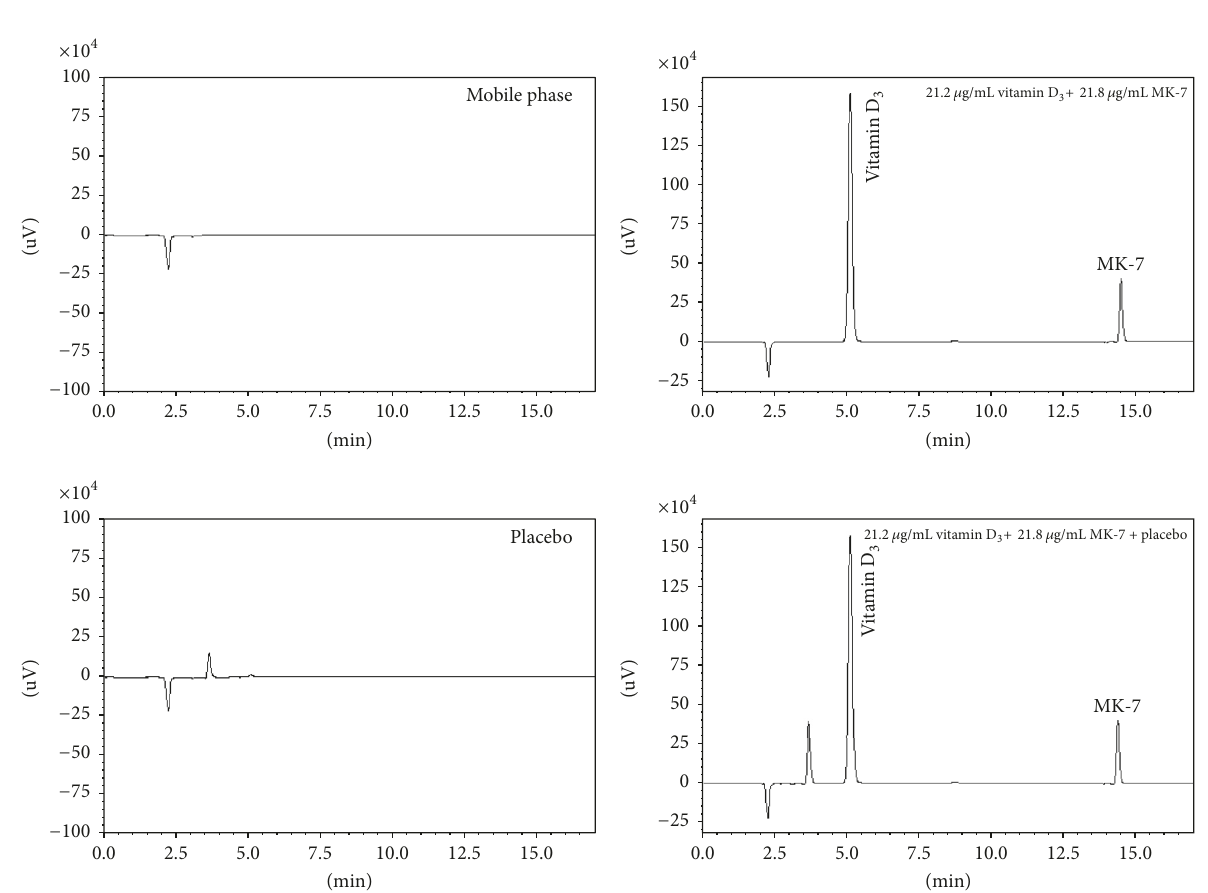
Figure 2: Typical HPLC chromatograms of vitamin D 3 and MK-7 with and without